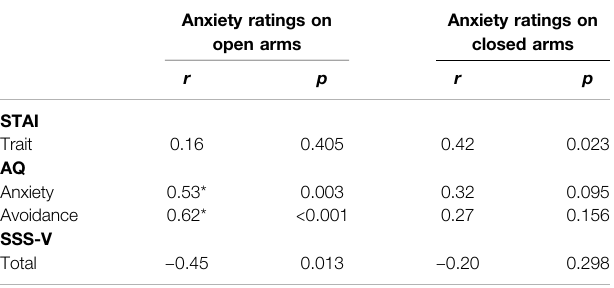
TABLE 3 | Results of correlation analyses of anxiety ratings with psychometric questionnaires. Anxiety ratings on open arms